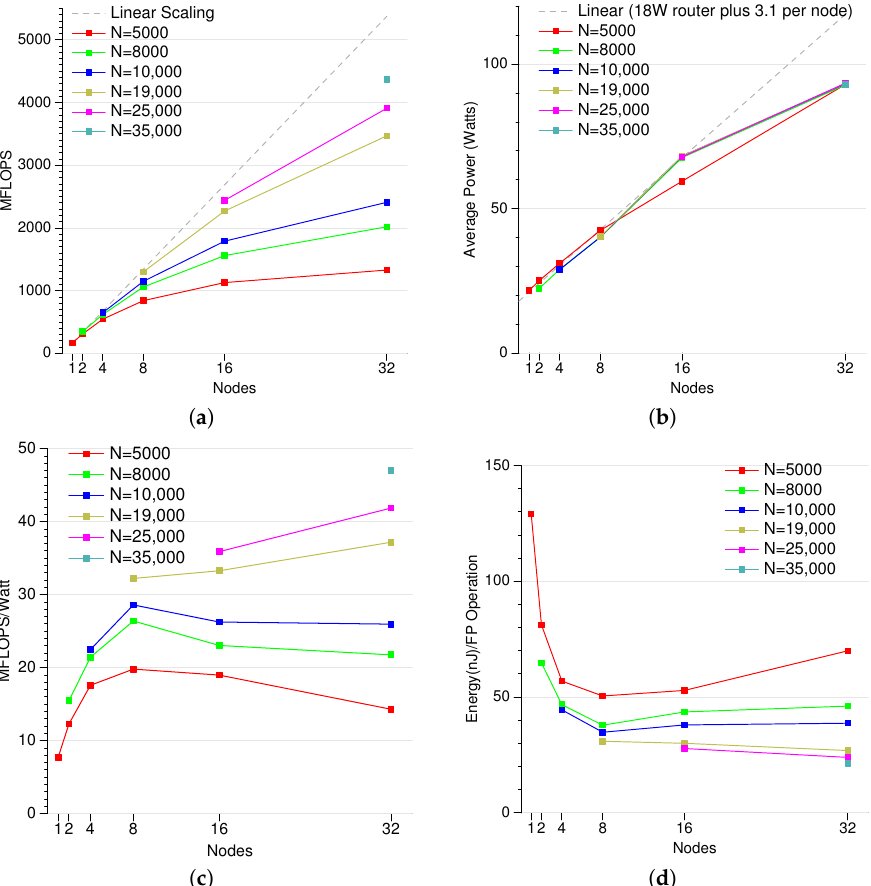
Figure 8. Scaling behavior of a 32-node B+ Cluster. ( a ) MFLOPS with the number of nodes for the Raspberry Pi cluster, no overclocking; ( b ) average power with the number of nodes for the Raspberry Pi cluster, no overclocking; the drop off with 32 nodes is because the additional 16 nodes use Model B+ (instead of Model B), which uses less power; ( c ) nanoJoulesper floating point operation with the number of nodes for the Raspberry Pi cluster, no overclocking; ( d ) nanoJoules per floating point operation with the number of nodes for the Raspberry Pi cluster, no